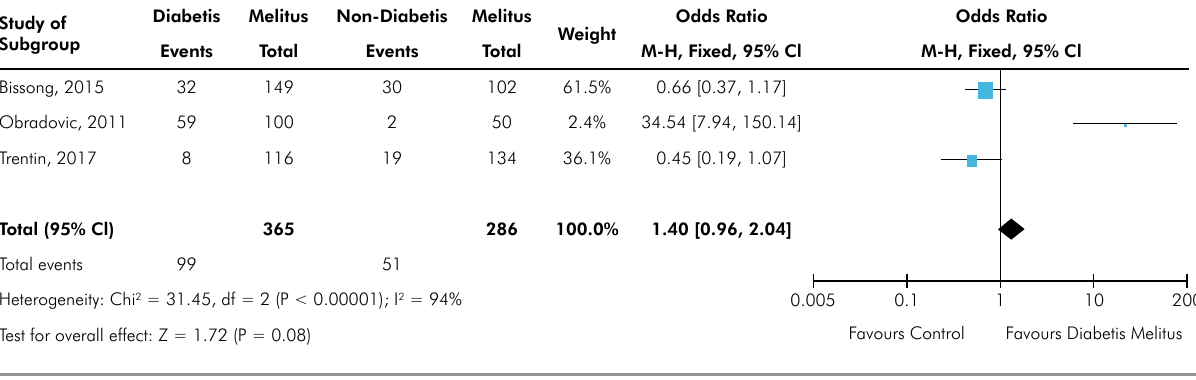
Figure 2. Forest plot of association between oral candidiasis and diabetes mellitus.